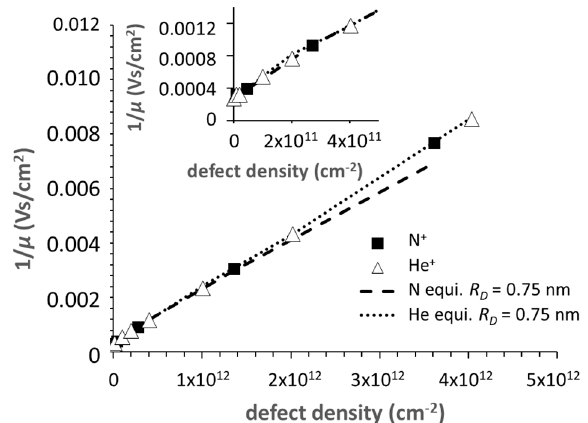
Figure 6. Dependence of inverse of hole mobility on defect density. Black points correspond to N + and open triangle points to He + implanted results. Dotted line is a linear approximation of the experimental points. Dashed and dotted lines represent formula (1) with defect radius R D = 0.75 nm using Hall carrier concentration data for N + and He + implanted samples respectively. The offset along the y-axis shown in insert indicates the presence of other types of scatters which are not created by implantation.